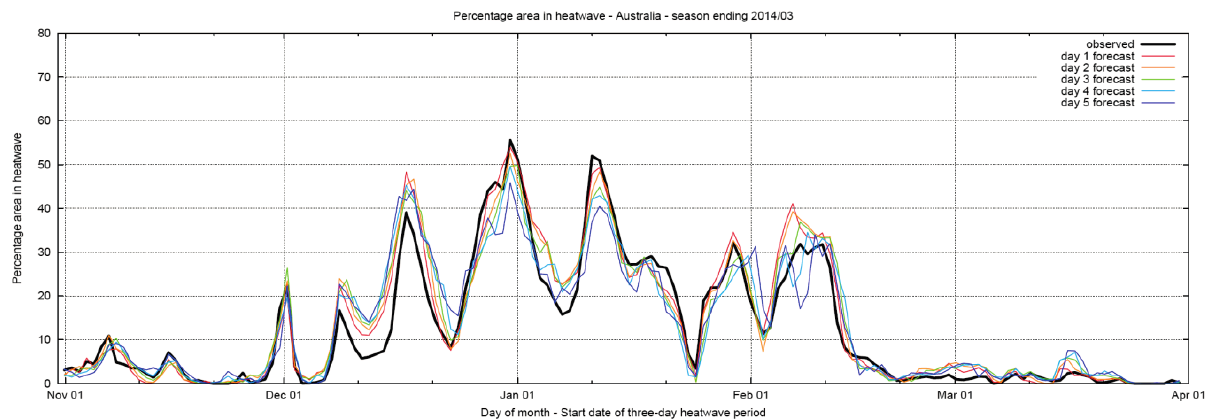
Figure A2. Percentage area of Australia in heatwave, as observed and forecast, across the period November 2013 to March 2014. The calculation is performed across continental Australia and the main island of Tasmania. Meridional convergence is taken into account when calculating the percentage